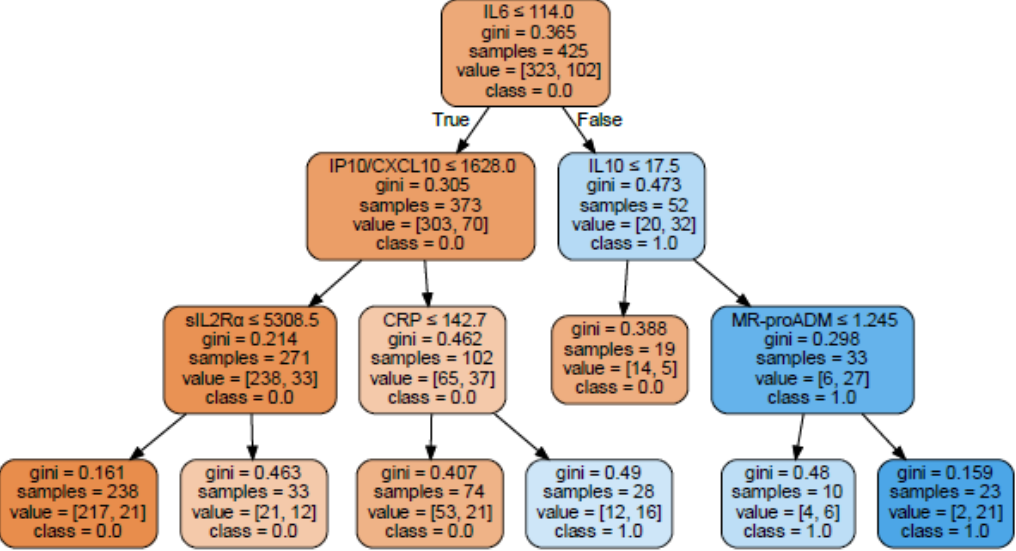
Figure 3. Classification tree for negative outcome risk. Classification tree with negative outcome (OTI and/or death) as target variable. Colour intensity is proportional to the purity of each node/leaf: orange for class 0.0 (not negative outcome), blue for class 1.0 (negative outcome). In each leaf, top to bottom: name of the variable with cut ‐ off for the subsequent population split (True vs. False); Gini index of the node; number of samples contained in the leaf; number of patients in class 0, 1 (value = [number of patients in class 0, number of patients in class 1]); dominant class (e.g., Class = 0.0). Gini index is a measure of “impurity” of the node, with pure nodes having Gini index of 0. The algorithm splits nodes based on the minimum value of Gini index.